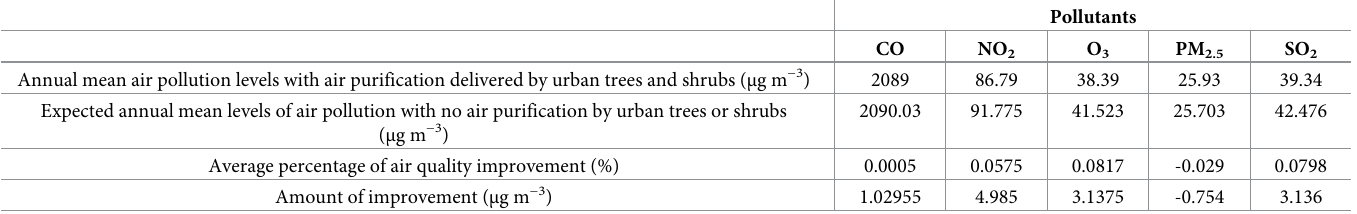
Table 3. Estimated air quality improvement due to air pollution removal by urban trees and